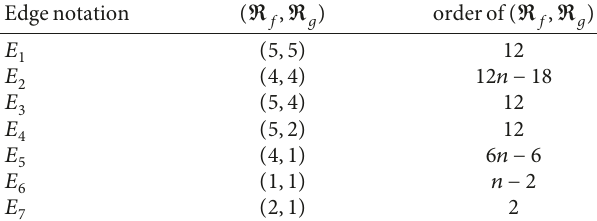
Table 3: Reverse degree-based edge partition.